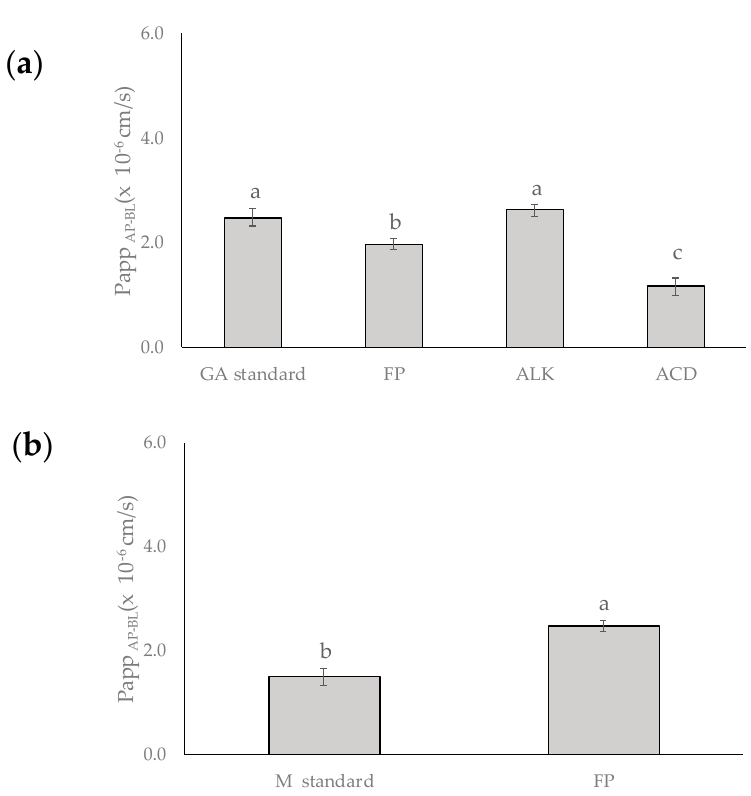
Figure 4. Apparent permeability (Papp) of ( a ) gallic acid (GA) and ( b ) mangiferin (M) present in free phenolic (FP), alkaline (ALK), and acid (ACD) fractions obtained from mango cv. Ataulfo peel, and their respective standards from apical to basolateral compartment (AP-BL).